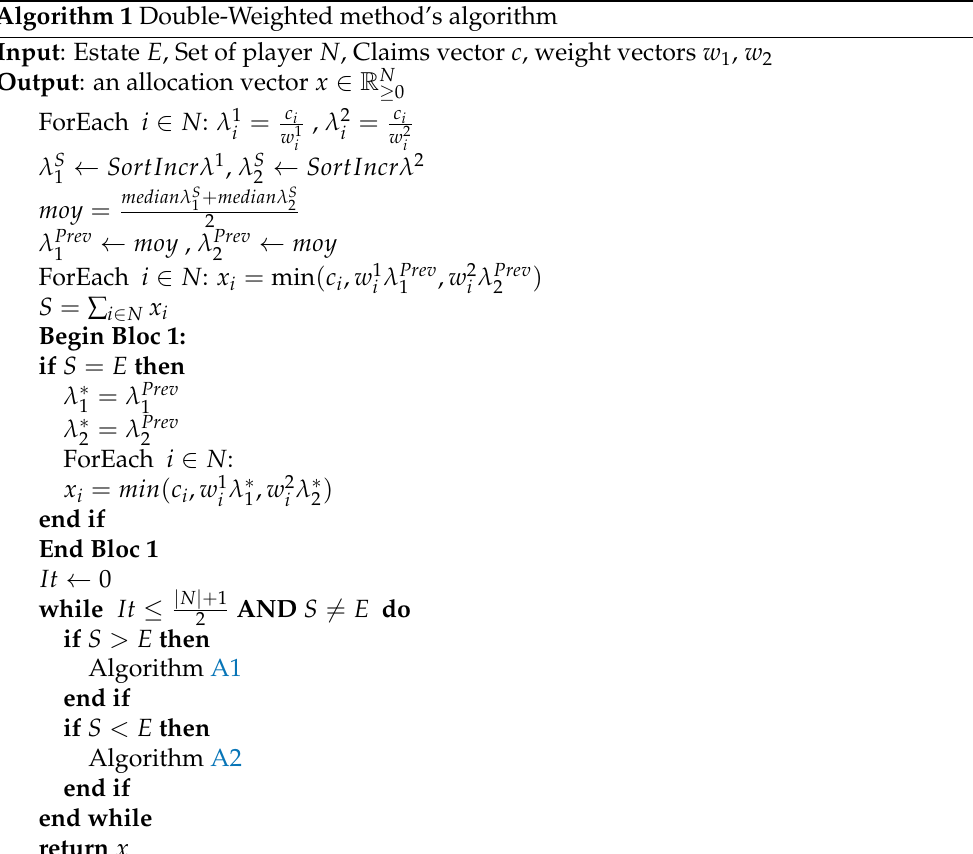
Algorithm 1 Double-Weighted method’s